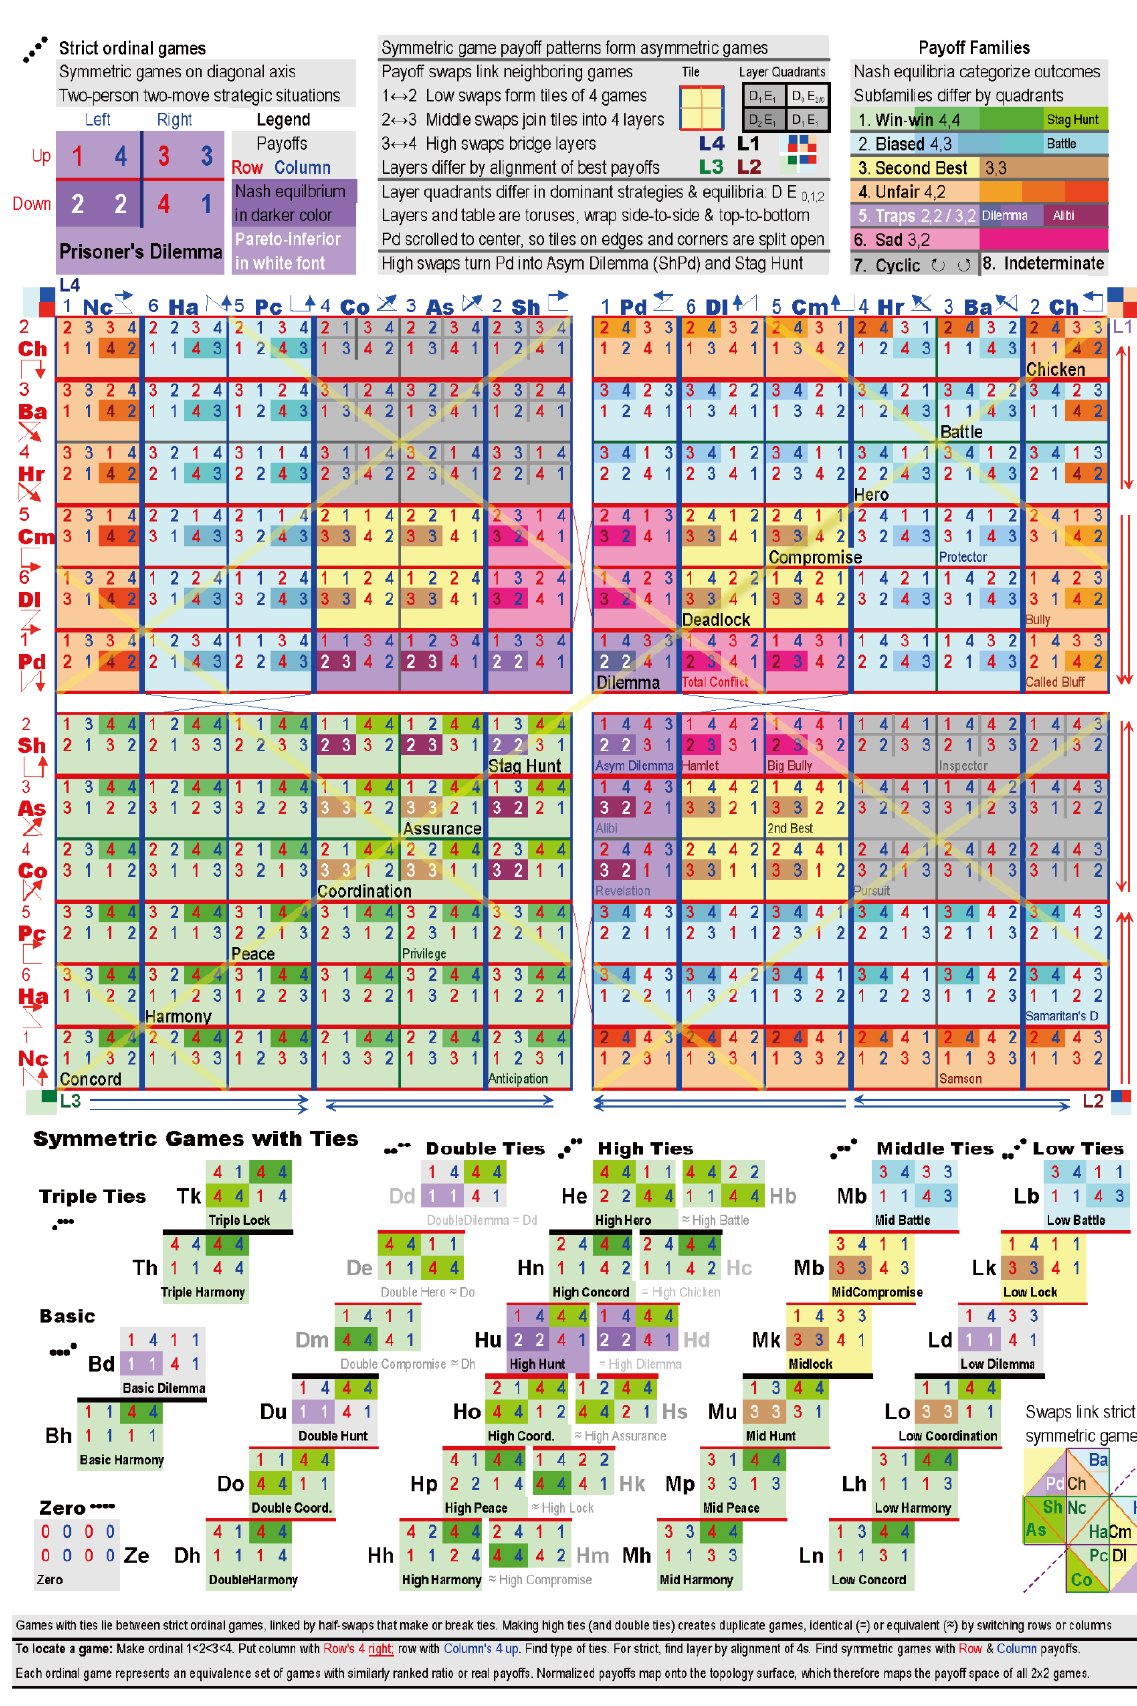
Figure 1. In the Topology of 2 × 2 Games, swaps in adjoining payoffs link strict ordinal games. Based on [2] and